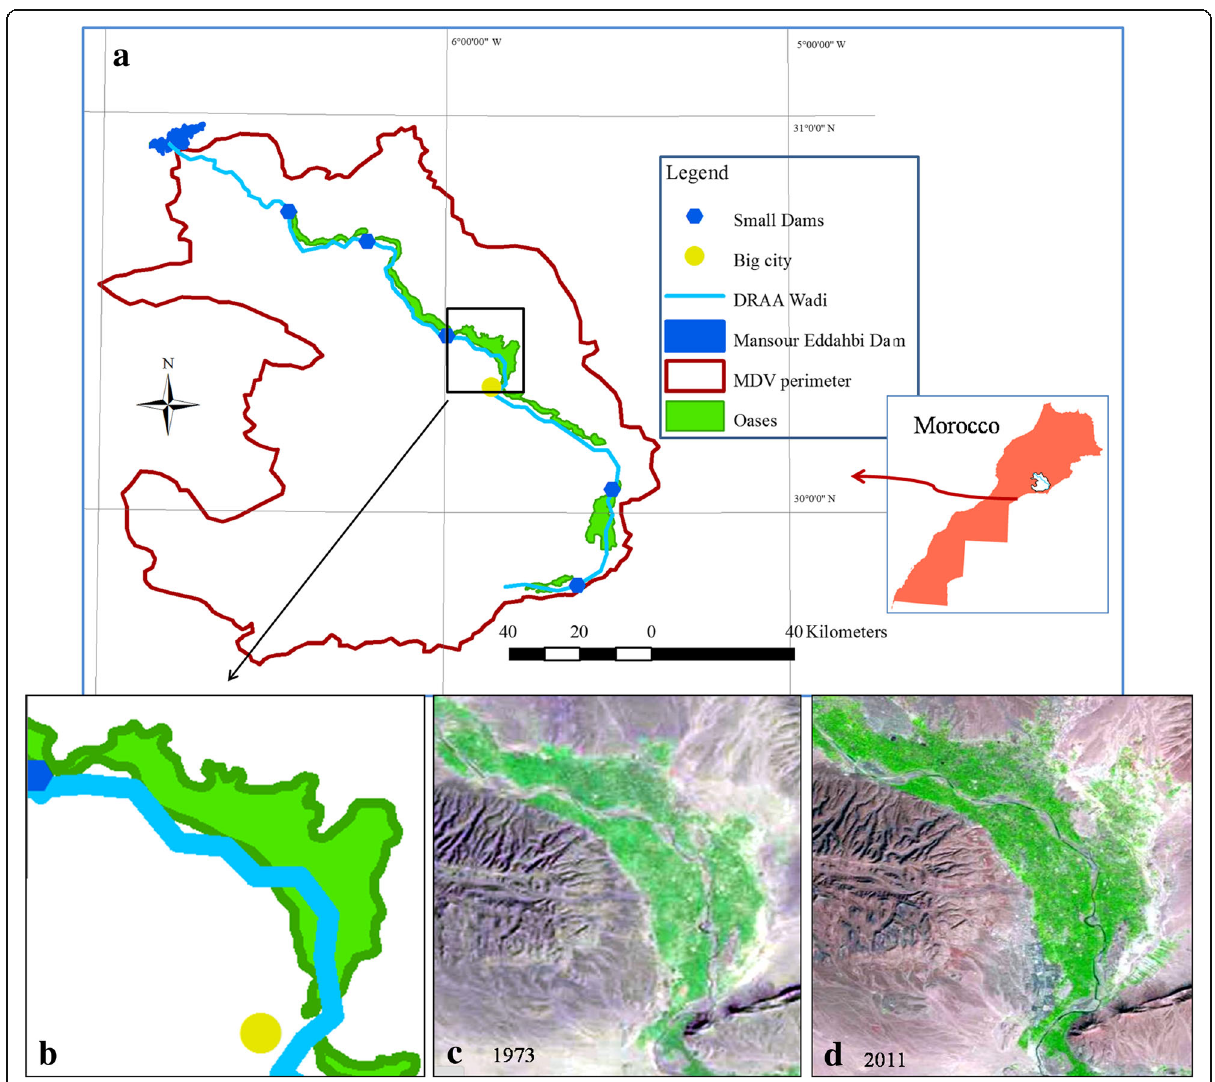
Fig. 1 Localization of Middle Draa Valley ( a ) in Morocco showing the Ternata Oasis ( b ), with the vegetation-cover in 1973 ( c ) and 2011 ( d ). Images c & d from USGS (U.S Geology survey) land sat